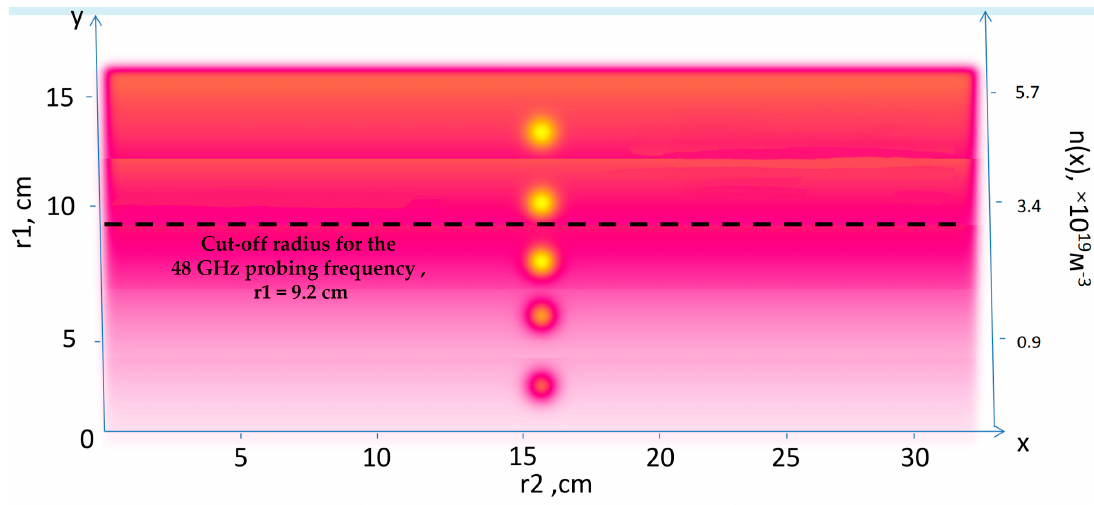
Figure 9. Density perturbations with an introduced series of circular filaments (yellow circles) positioned at different radii.